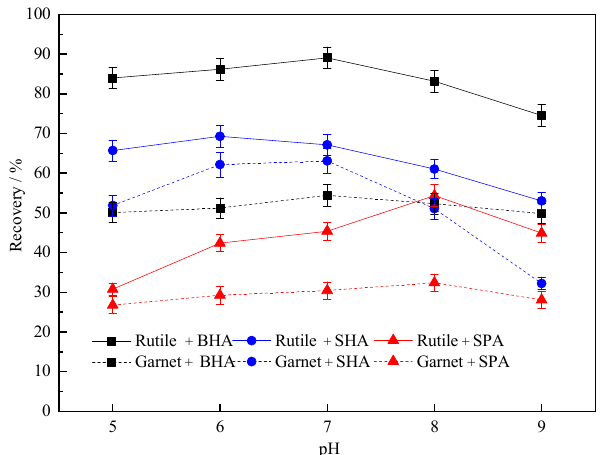
Figure 3. Effect of pH on the flotation of rutile and garnet with different types of collectors. (Concentration of collectors = 40 mg/L ).